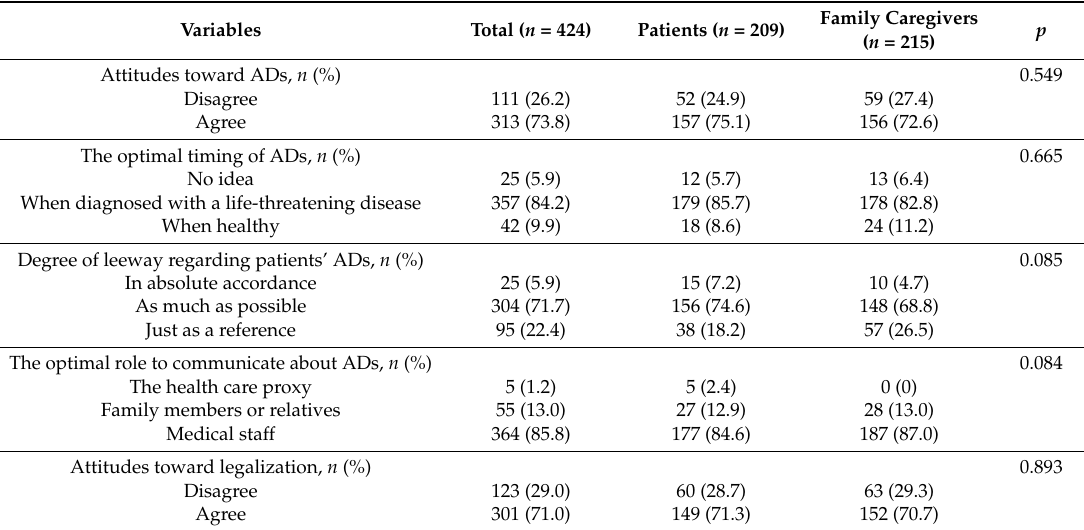
Table 2. Participants’ attitudes and perceptions toward ADs.